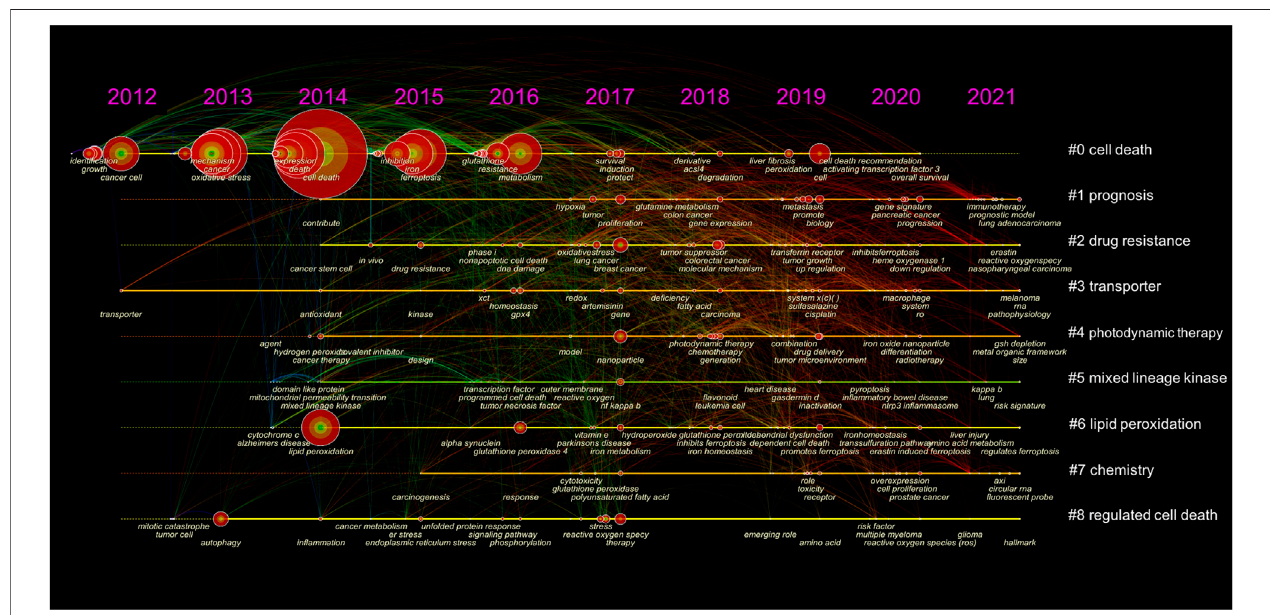
FIGURE 5 | The timeline view of keywords. The nodes represented keywords (the larger circle, the more frequency of occurrence). Clusters ’ labels were listed on the right.